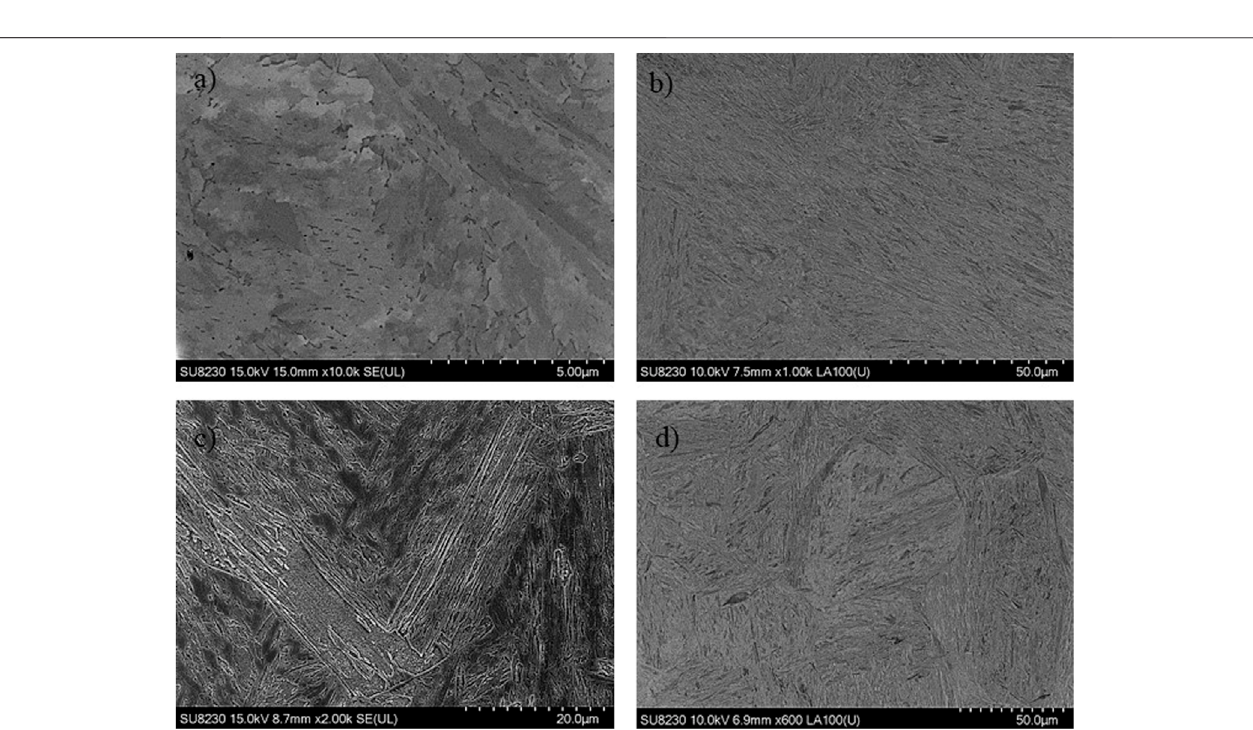
FIGURE 12 | Scanning electron microscopy (SEM) micrography of (A) as-received material, (B) deformed at 950 ° C 0.01 s − 1 , (C) deformed at 1,050 ° C 0.01 s − 1 , and (D) deformed at 1,250 ° C 0.01 s − 1 .